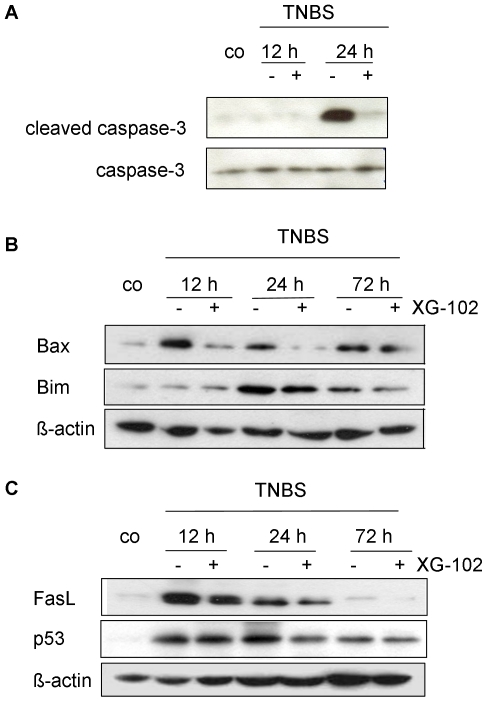
Apoptosis.Western blot analysis of (A) caspase-3 and cleaved caspase-3, (B) Bax and Bim, and (C) FasL and p53 from colon extracts of untreated controls (co) 12 h, 24 h and 72 h following trinitrobenzene sulfonic acid (TNBS) administration without or with XG-102 (100 µg/kg sc.). These blots are representative of 3 independent experiments.